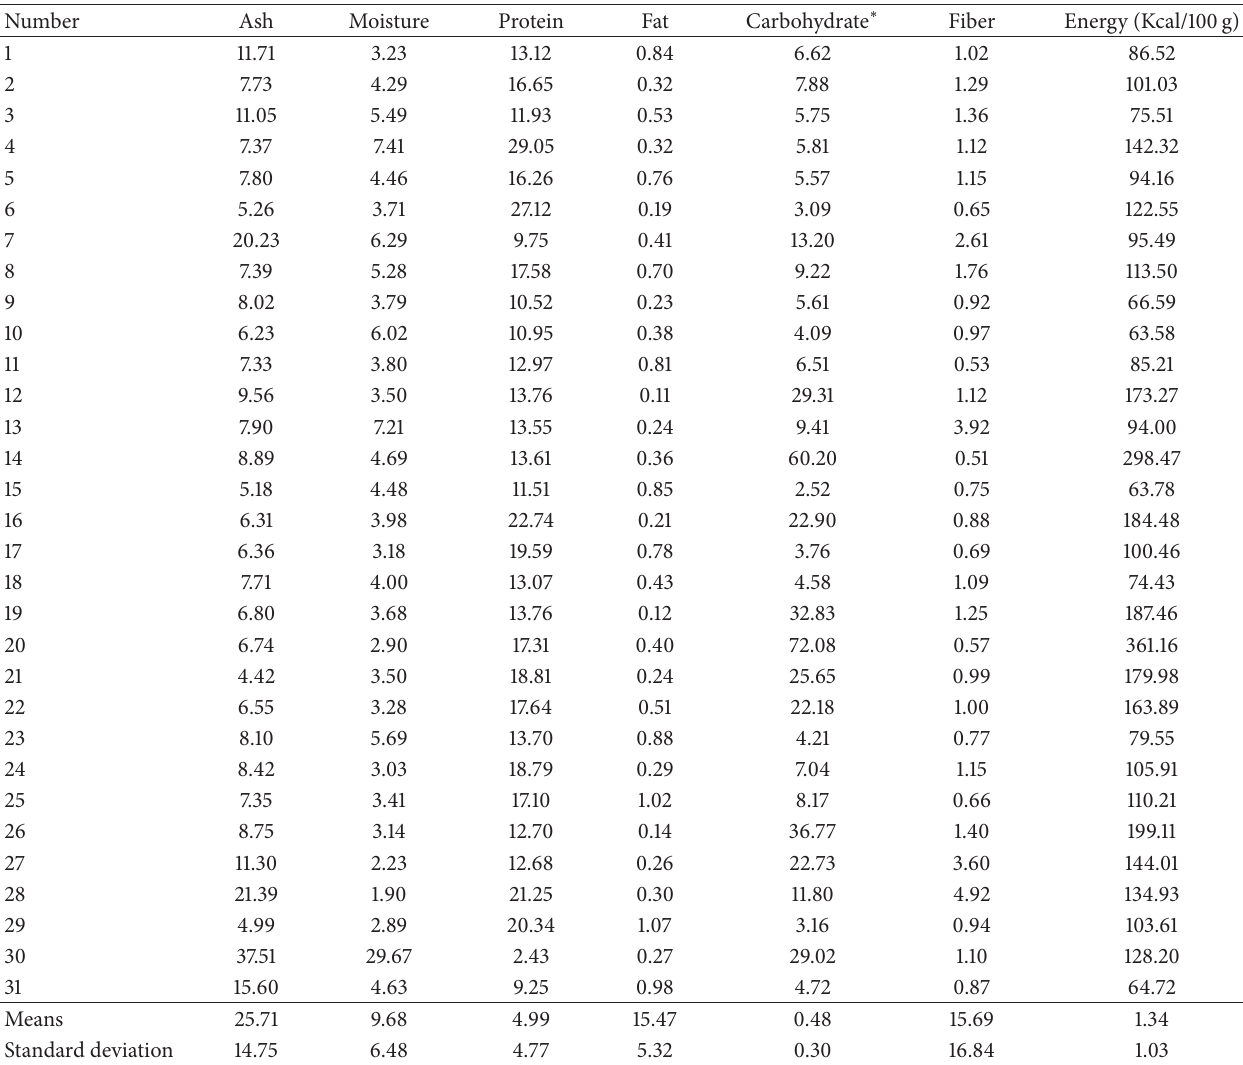
Table 1: Chemical composition of local formulas (g/100g) on fresh